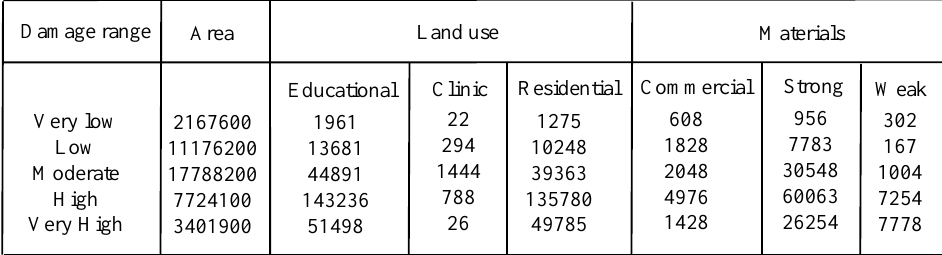
Area Damage range Land